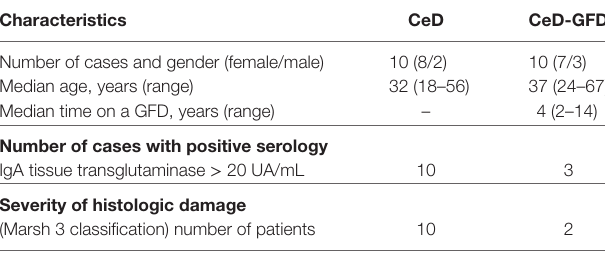
tABLe 1 | Analysis of duodenal biopsies from control subjects, untreated CeD patients, and CeD patients subjected to gluten withdrawal.